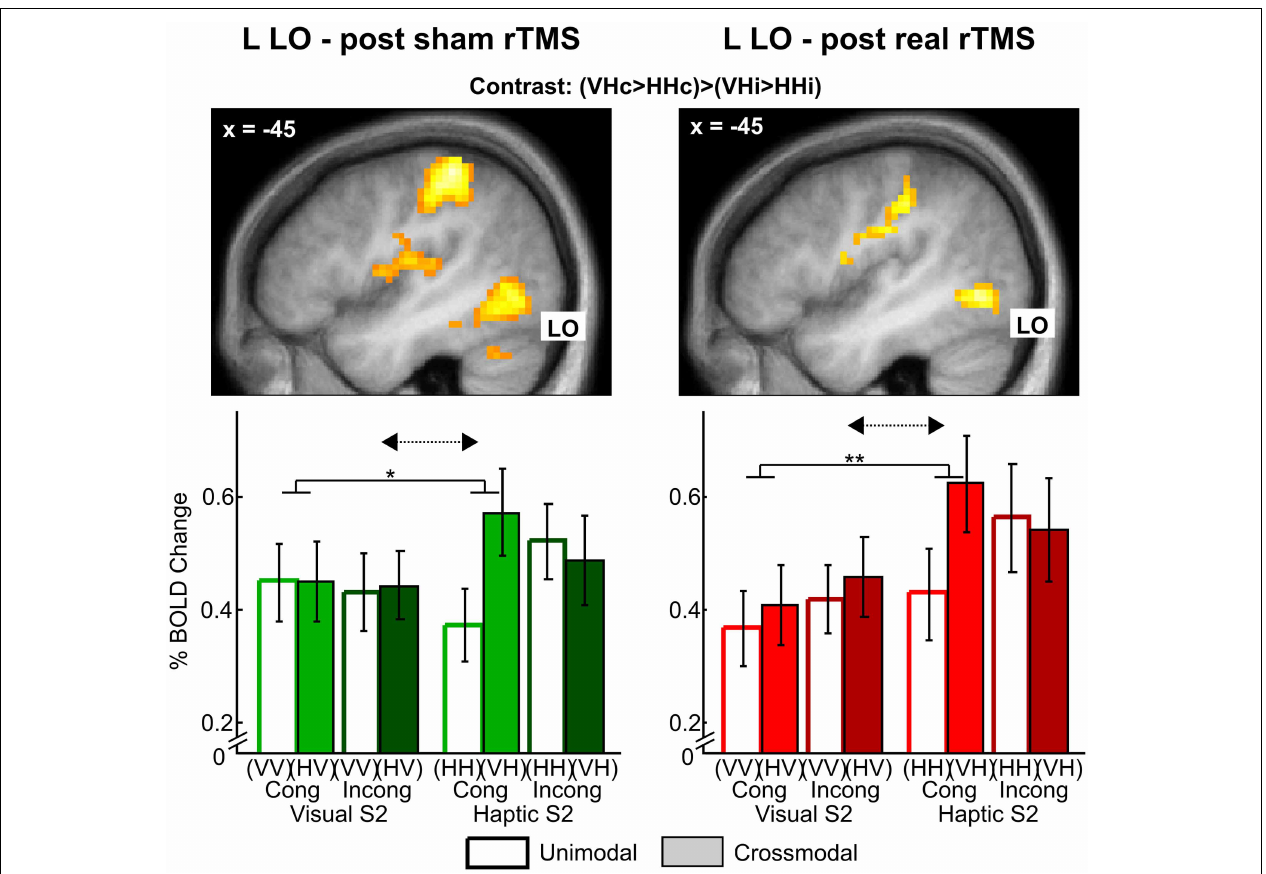
− 70, − 5). Stronger visuo-haptic interaction effects for haptic as opposed to visual S2 (solid lines: congruent crossmodal > unimodal × haptic S2 > visual S2, ∗ p < 0 . 05, ∗∗ p < 0 . 01, corrected; dashed arrows: crossmodal > unimodal x congruent > incongruent × haptic S2 > visual S2, p ≤ 0 . 063, corrected) were not affected by rTMS ( p > 0 . 01, uncorrected). Sample-target (S1-S2) conditions: V, visual; H, haptic; Cong, congruent;